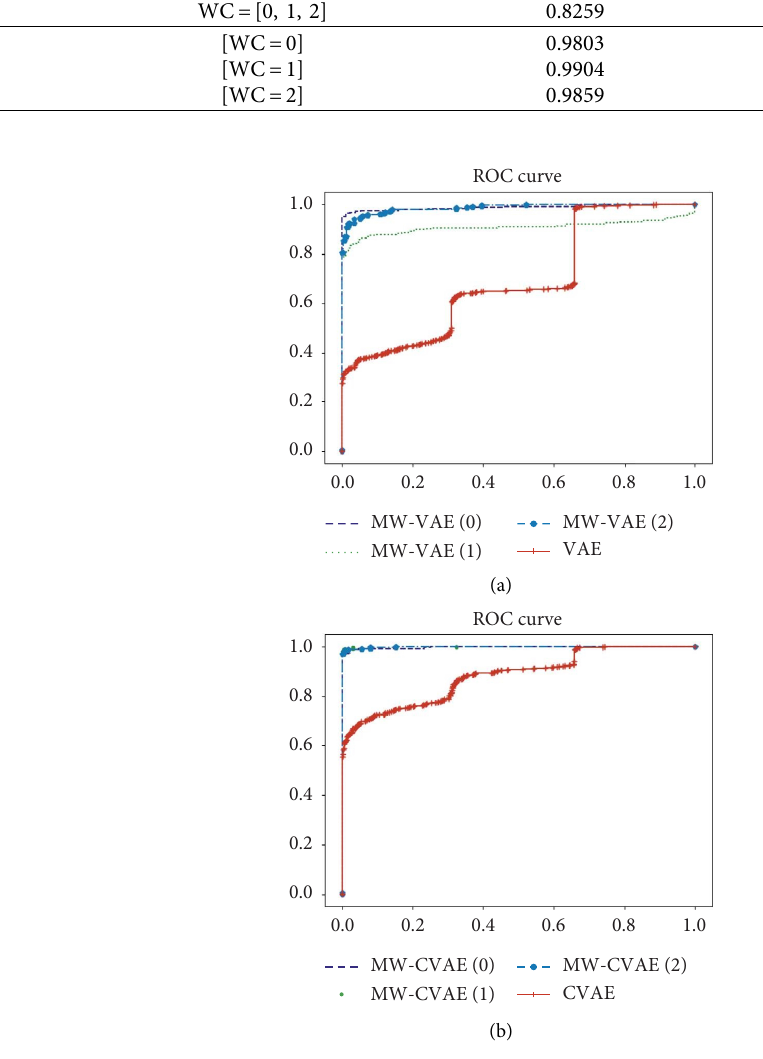
Figure 10: Comparison of ROC by MW-CVAE and MW-VAE for JNU dataset. Table 7: Anomaly detection accuracy of diferent methods.